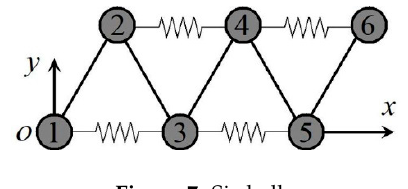
Figure 7. Six balls. Mathematics 2020 , 8 , x FOR PEER REVIEW